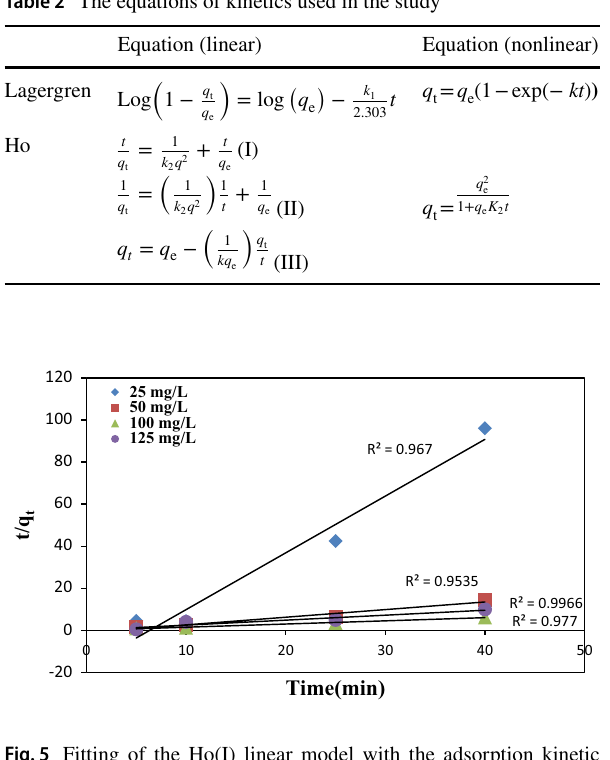
Fig. 5 Fitting of the Ho(I) linear model with the adsorption kinetic data